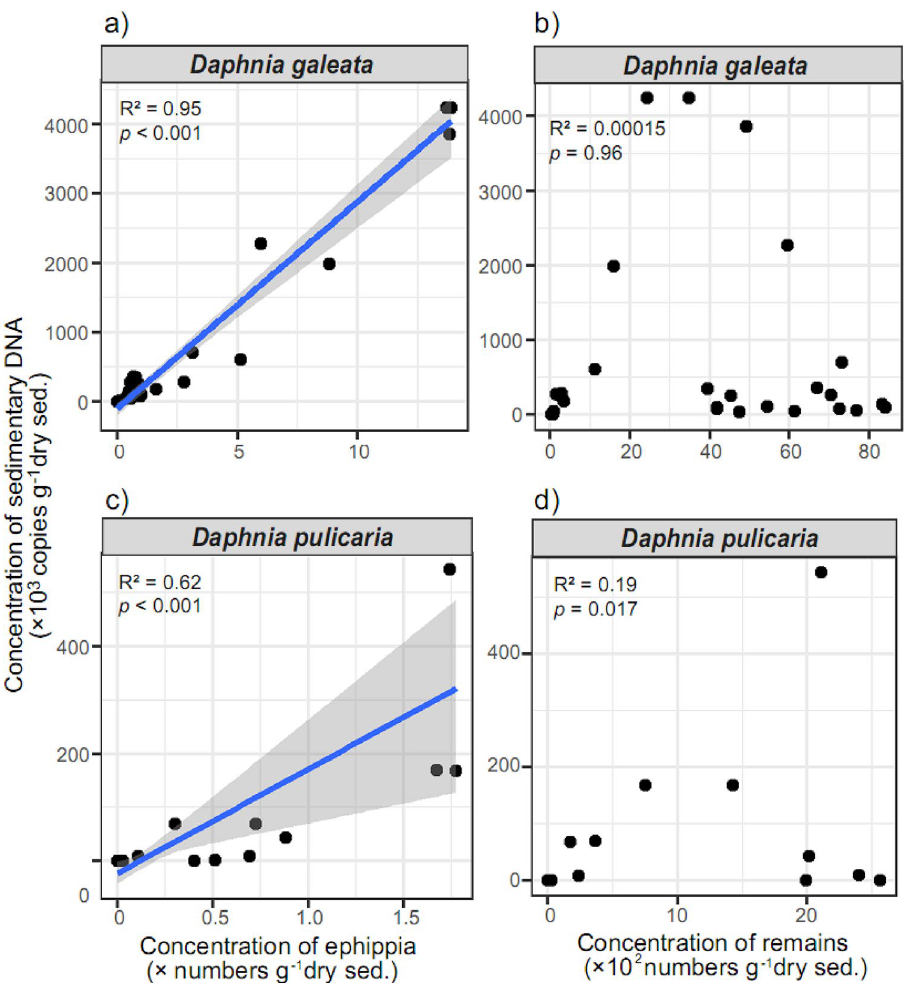
Figure 3. Relationships among the sedimentary DNA (copies of 12S rRNA gene g −1 of dry sediments), ephippia, and remain abundance (number g −1 of dry sediments) of Daphnia . The blue line denotes a regression line of Gaussian type II regression model with a 95% confidence interval indicated by the gray zone.